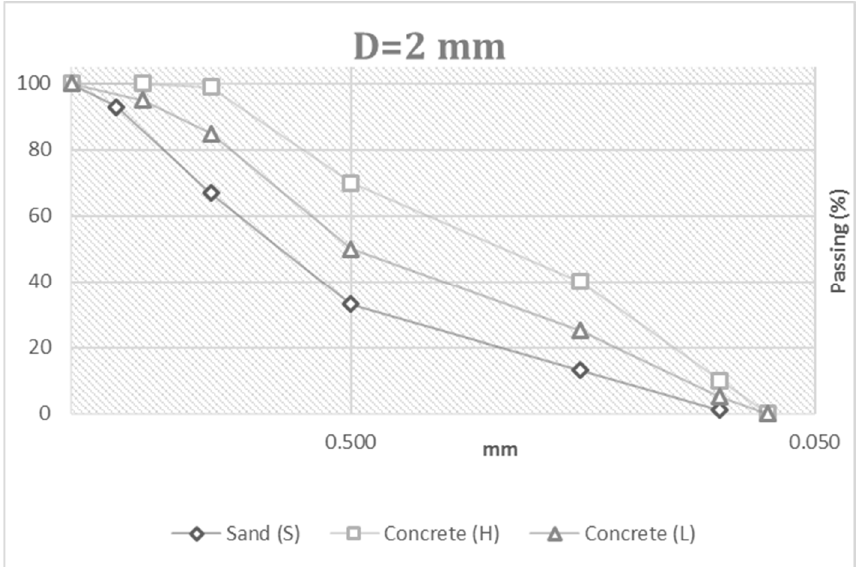
Figure 2. Particle size distribution of normalized sand, and the high and low limits for concrete.